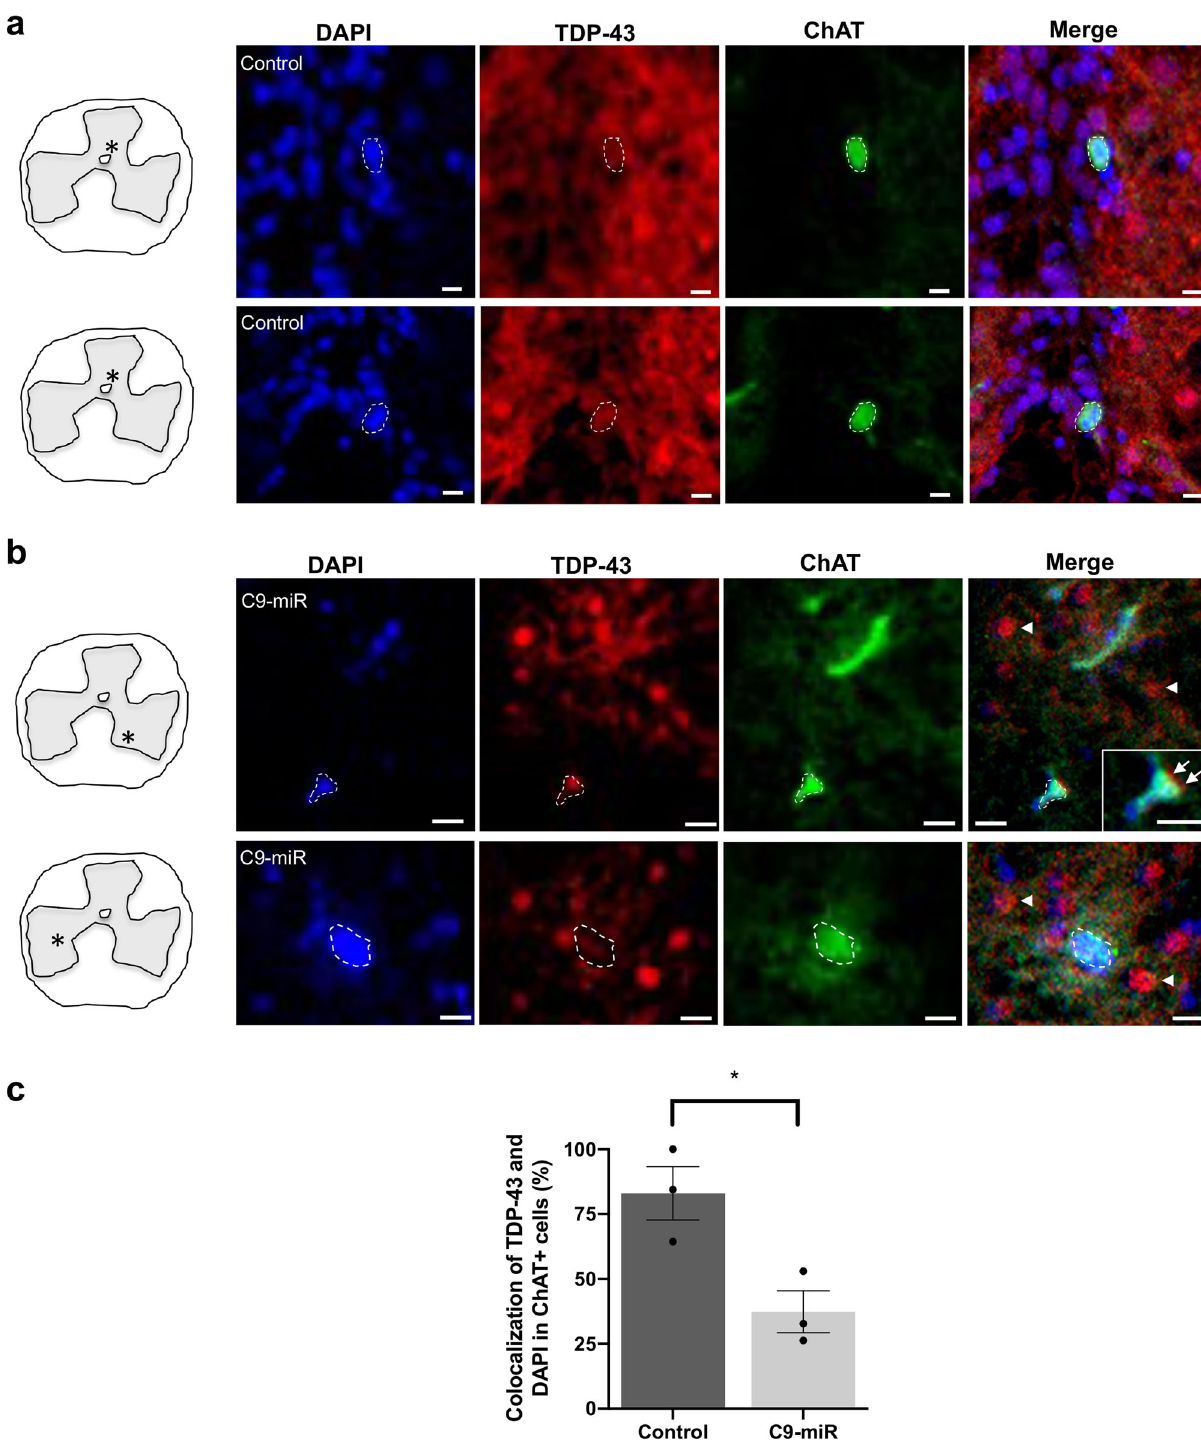
Fig. 6 TDP-43 pathology in adult C9-miR zebra fi sh motor neurons. Representative fl uorescence images of spinal motor neurons immunostained with antibodies against ChAT (green), TDP-43 (red) and labelled with DAPI (blue) in 14 – 16-month-old adult ( a ) control (wild type) or ( b ) C9-miR spinal cord sections. Scale bar = 20 μ m. Arrows and arrowheads illustrate TDP-43 mislocalization. c Quanti fi cation of colocalization (%) between the total cellular TDP-43 antibody signal and the nuclear DAPI stain in ChAT-positive motor neurons in C9-miR fi sh normalized to colocalization percentage in control fi sh ( n = 3; * p = 0.0251, Student ’ s t test). Data are presented as mean ± SEM. n represents the number of fi